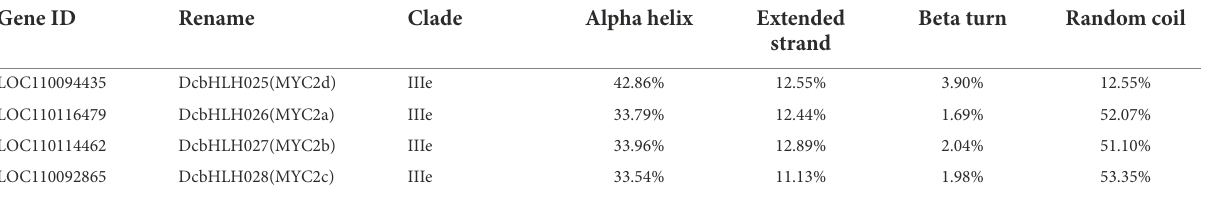
TABLE 2 Prediction of protein secondary structure of subgroup IIIe members. Gene